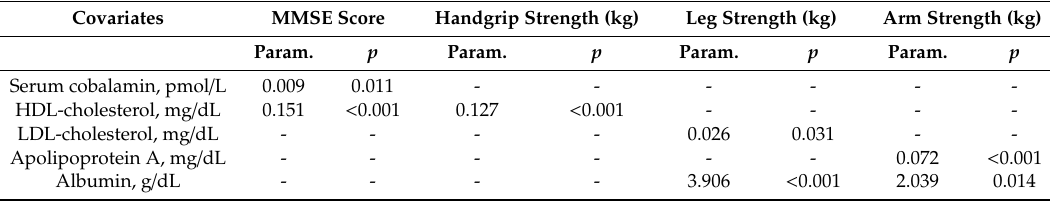
Table 3. MMSE score and functional tests results adjusted by biomarkers as covariate variables. Only significant e ff ects ( p < 0.05) are shown (linear mixed model).